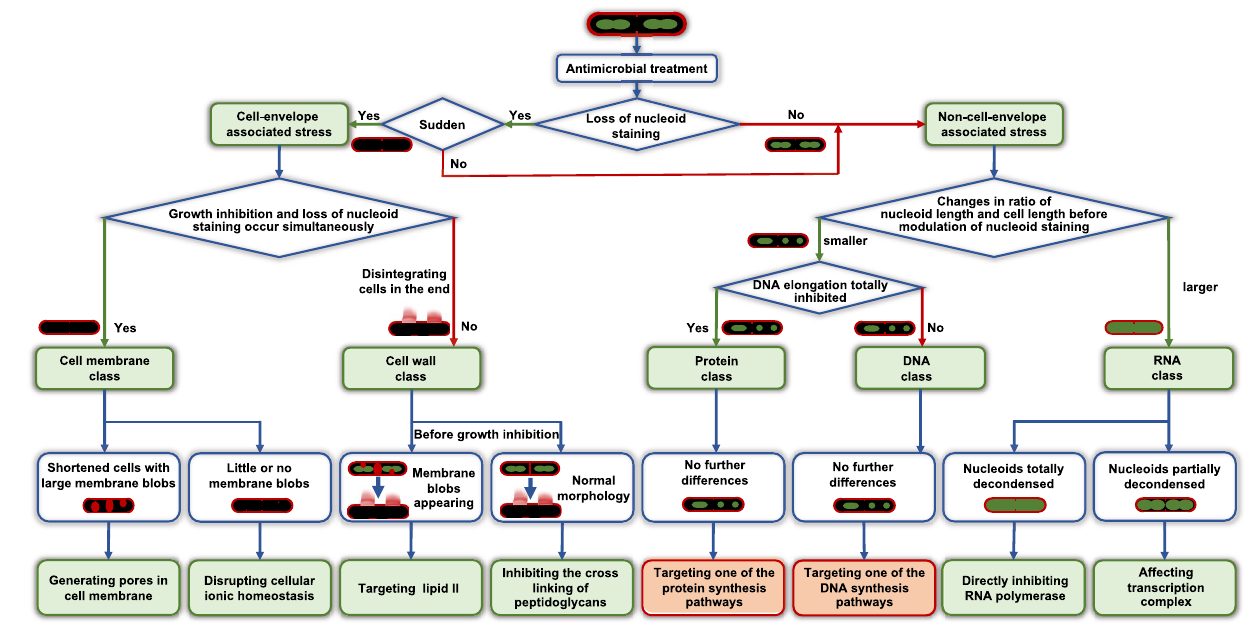
Figure 7. Schematic representation of the DBMI-guided antimicrobial MoA determination. Green boxes indicate well-identified categories or mechanisms, whereas red ones indicate less well-identified categories. DBMI distinguished antimicrobial MoAs at three levels. Briefly, B. subtilis cells were treated with antimicrobials and imaged. At the first level, based on the loss of nucleoid staining, every antimicrobial was grouped into cell- envelope associated stress or non-cell-envelope associated stress. If the nucleoid staining was suddenly lost (for example in response to ampicillin in individual cells, Figs. 3, 4b), the antimicrobials fell into the cell-envelope stress group. At the second level, five main MoA classes were discerned. For the group of cell-envelope stress, if growth inhibition and loss of nucleoid staining occurred simultaneously, the cell membrane was supposed to be affected. If growth inhibition occurred before loss of nucleoid staining, cell wall was determined to be affected if disintegrated cells were observed. For the group of non-cell-envelope associated stress, the difference in nucleoid length / cell length ratio before loss of nucleoid staining was measured. If the ratio increased during imaging, RNA synthesis was supposed to be affected. If the ratio decreased, the nucleoid growth was checked. If DNA elongation was inhibited, the antimicrobial was scored as protein class; if DNA elongation was not inhibited, the antimicrobial was scored as DNA class. At the third level, sub-classes were determined within cell membrane, cell wall and RNA classes. Protein and DNA classes could not be further distinguished because the differences within these classes were not evident. For the cell membrane class, if cells became shorter and large membrane aggregates were observed, pores were likely generated in the cell membrane. If there were little or no membrane blobs, the cellular ionic homeostasis was disrupted. To further distinguish within the cell wall class, we investigated early time points before growth inhibition. If cells appeared normal, the cross linking of peptidoglycans, which was the last step of cell wall synthesis, was likely affected. If thicker membrane septa or big membrane blobs were observed, lipid II synthesis might be affected. For the RNA class, the extent of nucleoid decondensing was different between different targets. If RNA polymerase was targeted, nucleoids would be decondensed completely. In case the transcription complex was affected, the decondensation of nucleoids would be less